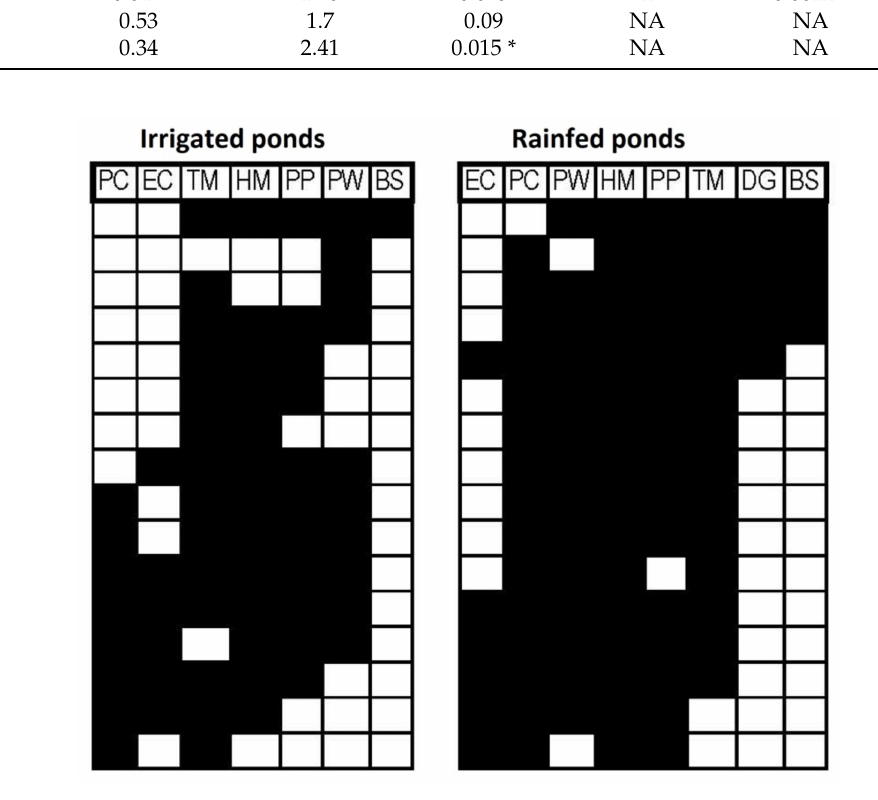
Figure 4. Occurrence matrices of all amphibian species in irrigated ( left ) and rainfed ( right ) ponds, ordered by maximum coherence following EMS analysis. Black boxes indicate species presence (columns) in each pond (rows). EC: Epidalea calamita , PC: Pelobates cultripes , PW: Pleurodeles waltl , HM: Hyla molleri , PP: Pelophylax perezi , TM: Triturus marmoratus , DG: Discoglossus galganoi , BS: Bufo spinosus